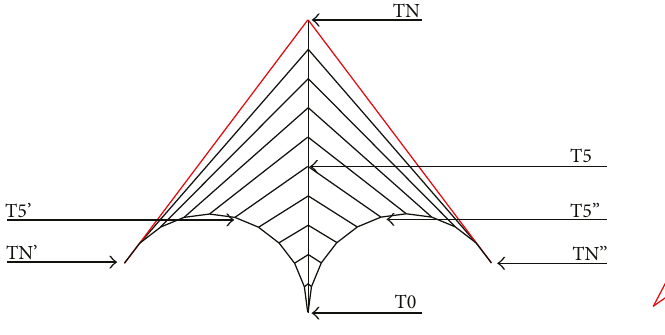
Figure 3: STS schematics.